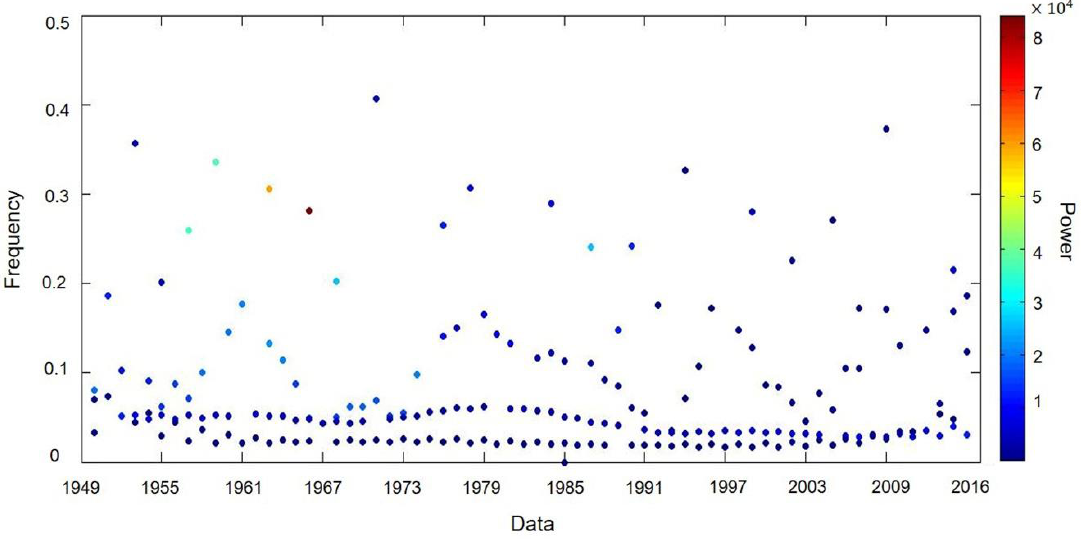
Figure 15. The Hilbert spectrum for the 67 m series of HHS.